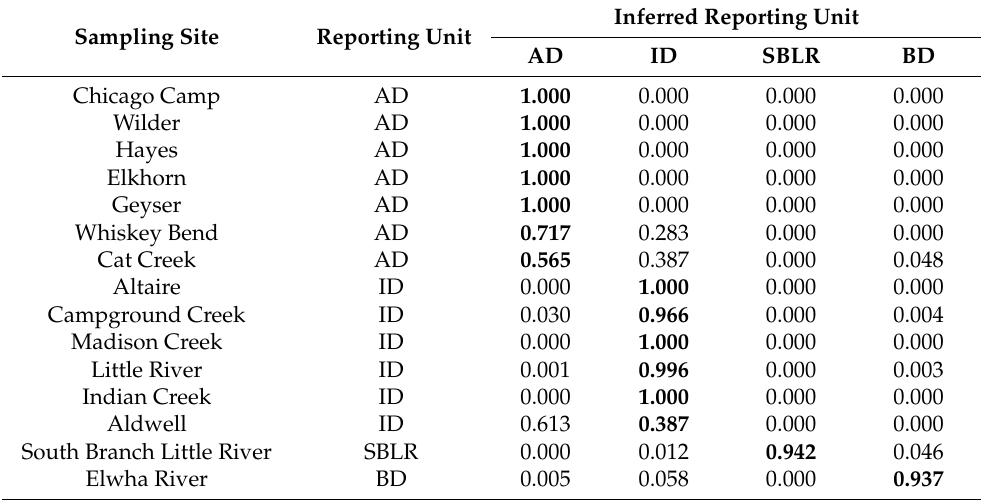
Table A1. The accuracy of assignment of individuals in the reference collections used in GSI analysis (ii) were lower than those used in GSI analysis (i). Simulations performed on all 567 individuals sampled pre-dam removal using SNP set 2 reflected high accuracy of assignment on average across individuals in each reference collections back to their respective reporting units. The posterior likelihoods for reporting units’ assignment displayed above reflects the mean of the reporting unit scaled likelihoods of assignment based on collection membership within the reporting unit. The reporting unit scaled likelihood is calculated by taking the summation of the likelihoods of assigning a fish back to the inferred reporting unit. Posterior probability of assignment for Aldwell, Cat Creek and Whiskey Bend was low compared to GSI analysis (i). Bolded values indicate the highest mean posterior likelihood for inferred population assignment.